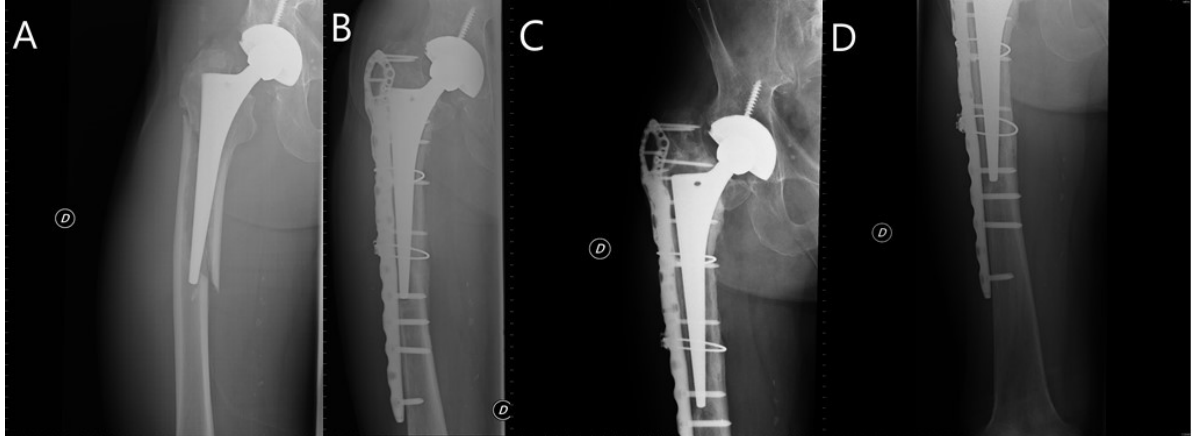
Figure 2. Woman 77 years-old, Vancouver B2 PPHF treated using ORIF. ( A ) Fracture; ( B ) 6-month control (consolidated fracture); ( C , D ) 18-month control.